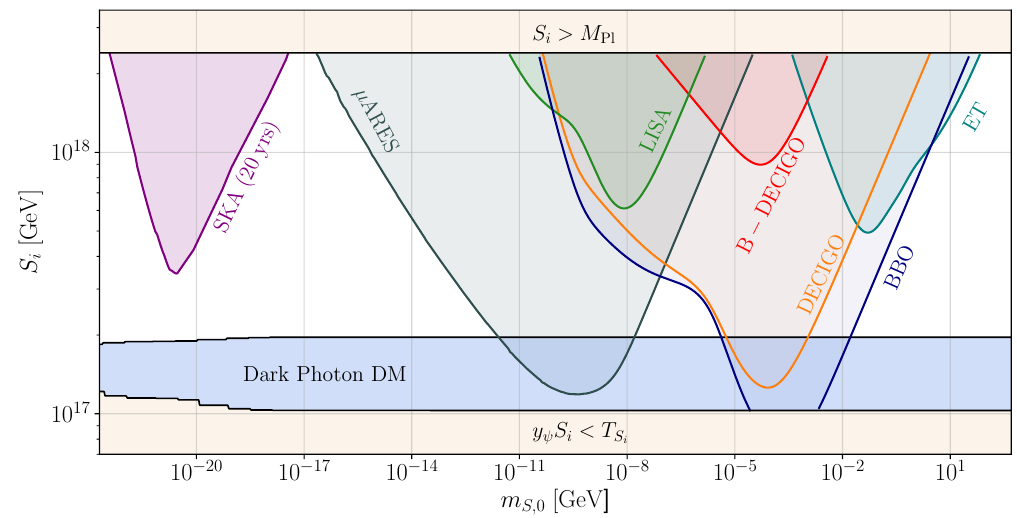
− m Figure 8: The parameter regions in the S plane that are probable in the future, i S ,0 for the benchmark parameters f φ = 10 12 GeV and α = 0.02. Since the GW amplitude is independent of f φ , the presented model provides detectable signals for any value of f φ . Hence, also the parameter region that is subject to direct axion searches may be probed via GWs in the future. In the entire parameter space, the ALP can constitute DM, since the GW production is independent of m φ . The blue shaded region marks where the dark photons, if they were massive, are sufficiently cold to be DM, but also do not overclose the Universe at T MR